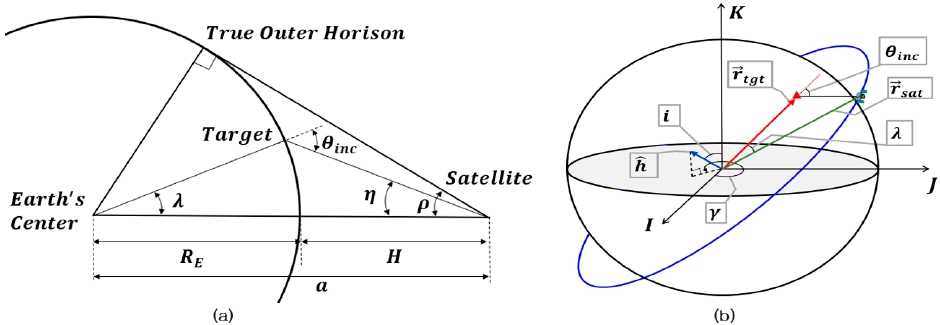
Figure 11. Geometric relationships between Earth’s center, ground target, and satellite; 2D ( a ) and 3D ( b ).